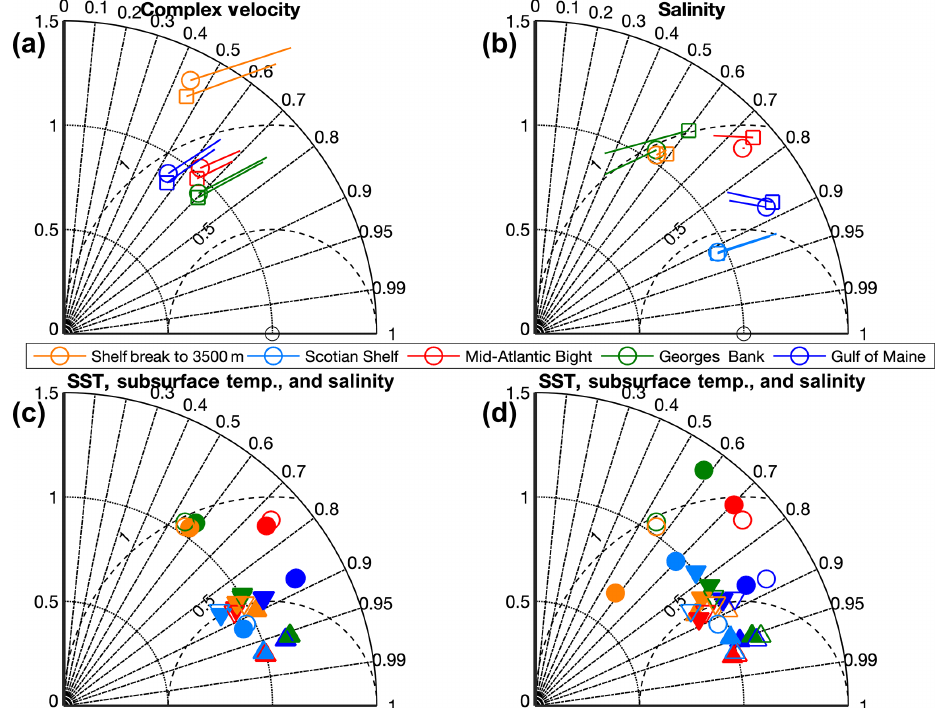
Figure 7. Taylor diagrams of model skill for the different model setup cases. Symbols are colored according to subregions defined in Fig. 6. (a) Complex velocity is shown with (square) and without (circle) the change to the bulk formula calculation for wind stress relative to surface current. (b) Salinity is shown for TMPA (square) against NARR (circle) precipitation forcing. (c) SST ( (cid:49) ), subsurface temperature ( ∇ ), and salinity (circle) are shown for Mercator open-boundary data not corrected for bias (filled) against bias-corrected open-boundary Mercator data (unfilled). (d) SST ( (cid:49) ), subsurface temperature ( ∇ ), and salinity (circle) are shown for HYCOM open-boundary data not corrected for bias (filled) against bias-corrected open-boundary Mercator data (unfilled). No bias lines are shown for (c) and (d)